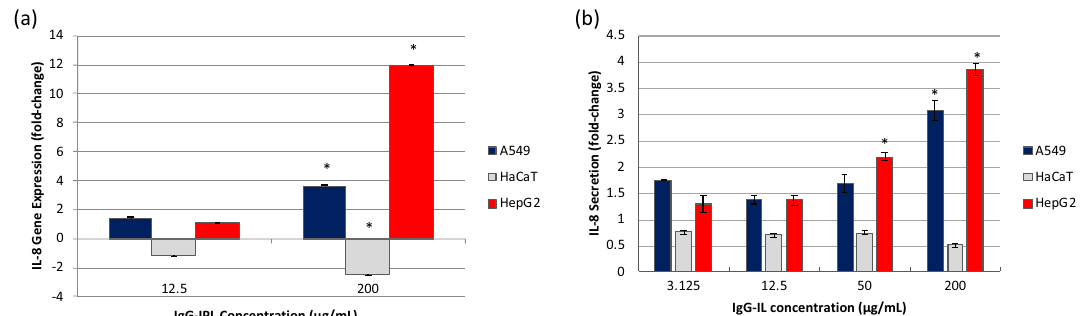
Figure 6. IL-8 ( a ) gene expression and ( b ) cytokine secretion results post-24 h exposure to IgG-IL for A549, HaCaT, and HepG2 cells. Results are presented as fold-change with respect to the no treatment